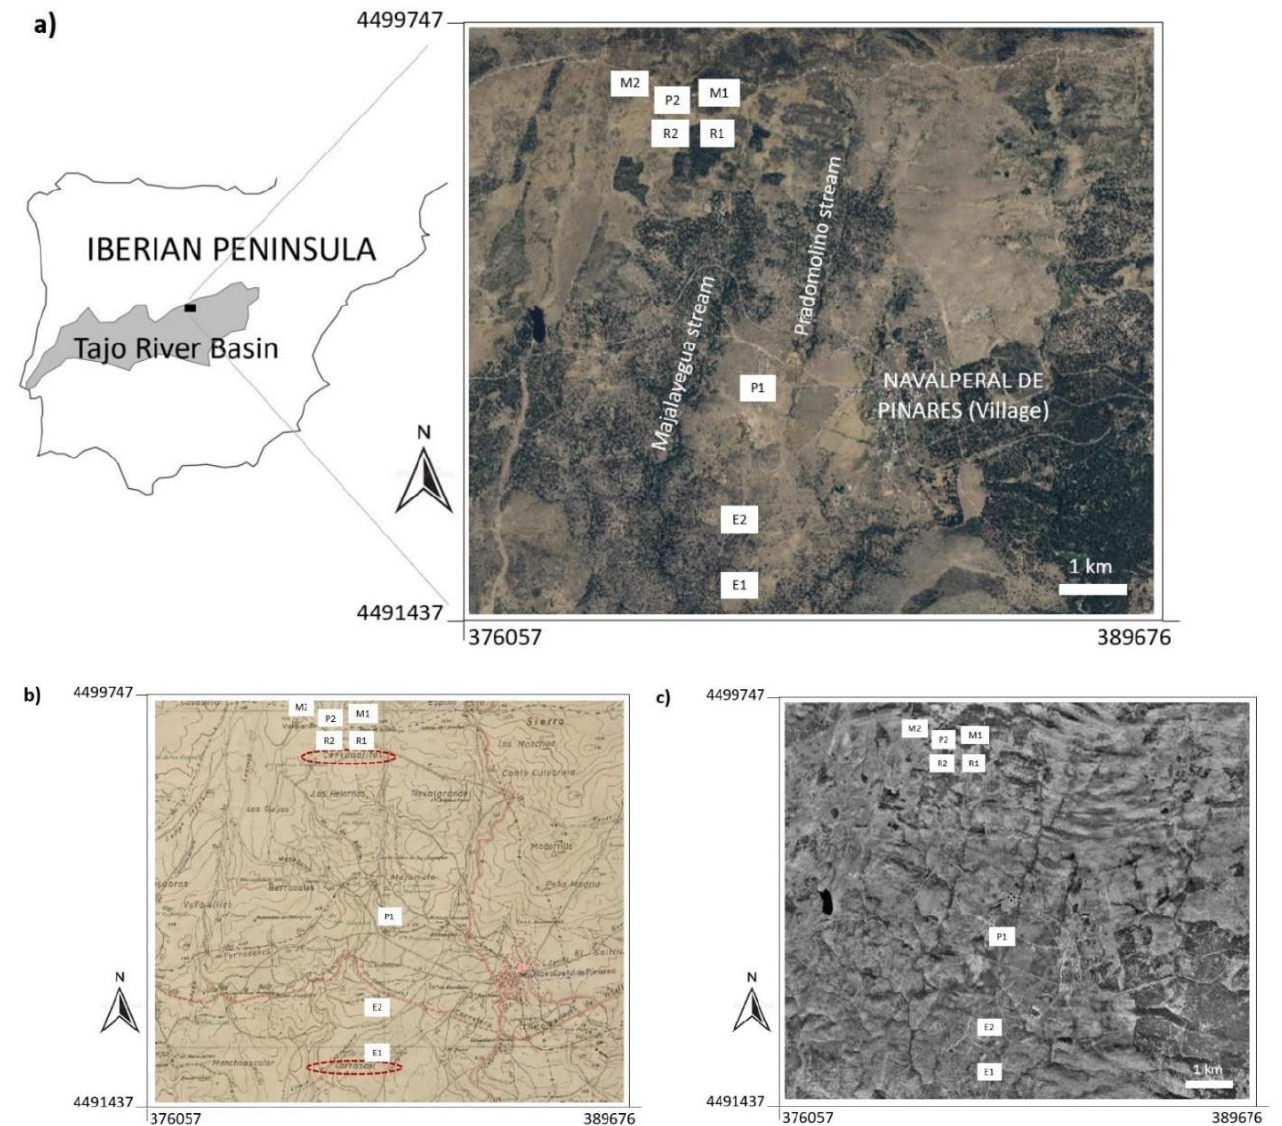
Figure 1. ( a ) Location of the study area in the Tajo River basin and the location of the sampling plots (R1, R2, E1, E2, M1, M2, P1, P2), using orthophotography PNOA 2017; ( b ) location of the study area in topographic map 1915; ( c ) location of the study area via ortophotography OLISTAT 1997–1998, before afforestation. Coordinates: UTM zone 30N, Datum ETRS89.